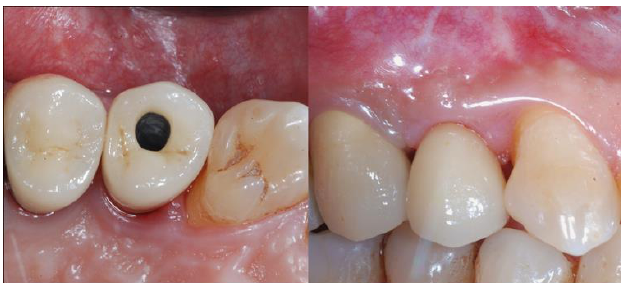
Figure 7. Delivery of the definitive screw-retained metal-ceramic rehabilitation: on the left the occlusal view and on the right the buccal view.